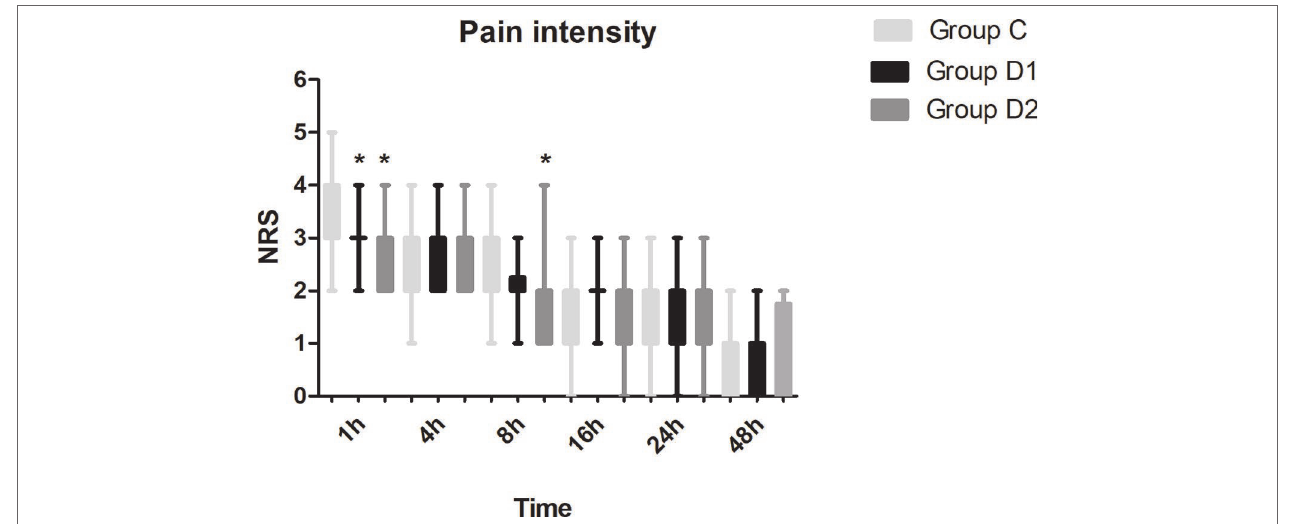
FIGURE 5 | Postoperative pain intensity in the three groups expressed as scores on a numerical rating scale (NRS) out of 10. * P < 0.05 vs. group C.